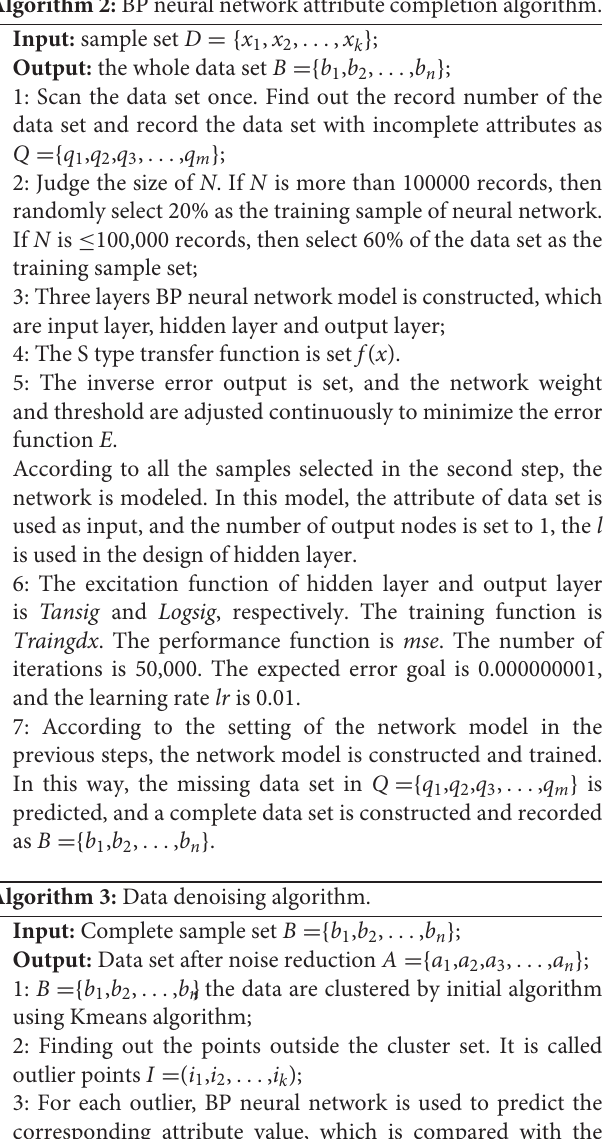
Algorithm 2: BP neural network attribute completion algorithm.